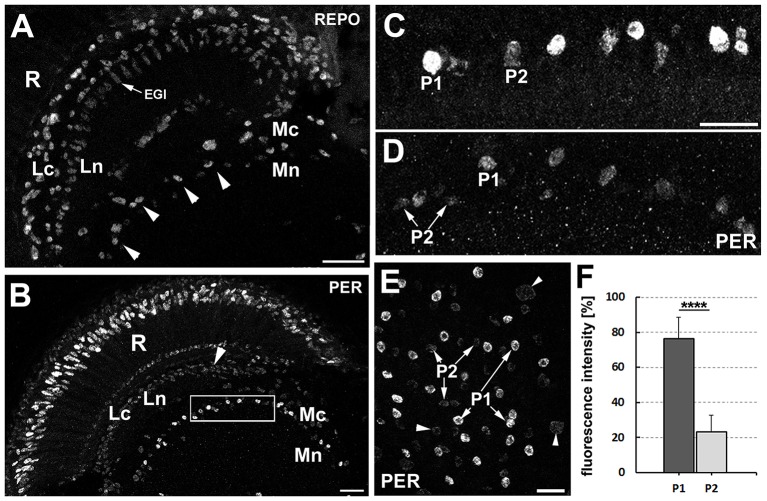
(A) Location of the distal medulla neuropil glia (dMnGl) among other glial cells that are marked by REPO-specific immunofluorescence in the optic lobes (frontal section). The nuclei of the dMnGl (arrowheads) reside at the border between the cortex (Mc) and the neuropil (Mn) of the medulla. R, retina; Lc, lamina cortex; Ln, lamina neuropil; EGl, epithelial glial cells. Scale bar: 20 μm. (B) Frontal section of Pdf0 optic lobe immunolabeled with anti-PER antibody. R, retina; Lc, lamina cortex; Ln, lamina neuropil; Mc, medulla cortex; Mn, medulla neuropil. The nuclei of the dMnGl (frame) reveal high level of PER-specific immunofluorescence in comparison with the nuclei of glia in Lc (arrowhead). Scale bar: 20 μm. (C,D) Small fragments of the Mc/Mn interface of Pdf0
(C) and CS (D) shown in higher magnification reveal the unexpected presence of the dMnGl displaying low level of fluorescence (P2). The P2 cells are well visible in Pdf0
(C). They are positioned next to cells of high fluorescence (P1) in almost alternating order. Such arrangement can be also observed, although less clearly, in CS (D). The images shown in (C,D) were collected at the same image acquisition parameters. Scale bar for (C,D): 10 μm. (E) The frontal surface of Pdf0 medulla. The fluorescence in P2 is comparable to the fluorescence in glial cells of the medulla cortex (arrowheads). Scale bar: 10 μm. (F) The average level of fluorescence (±SD) in P1 and P2 cells of Pdf0 (****p < 0.0001).